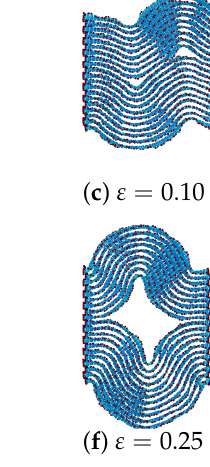
Figure 3. Deformation of armchair graphite under compression ( n = 20).